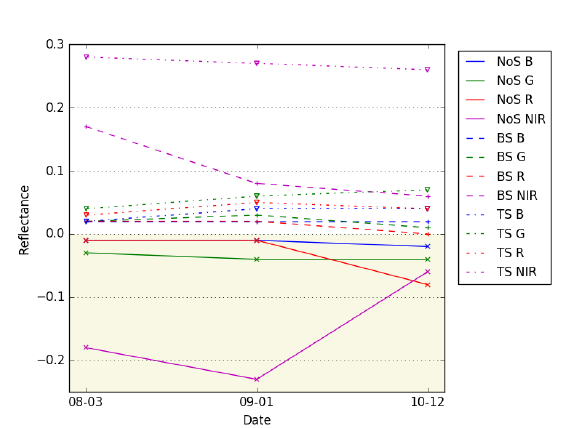
Figure 3: Temporal development of the extracted larch re- flectances without shadows considered, with binary shadows con- sidered and the terrain shadow parametrization applied. NoS stands for the no shadows-method, BS means binary shadows and TS is short for terrain shadows. The physically not reasonable range is shaded in yellow.